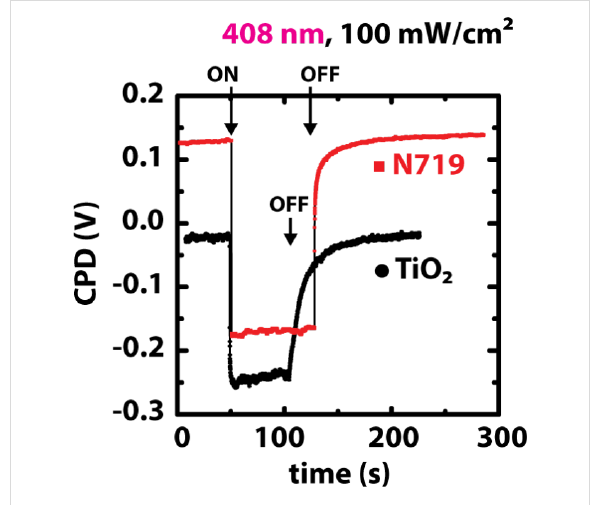
Figure 7: Time evolution of the measured CPD of TiO 2 and TiO 2 + N719 during the turning on and off of the violet (408 nm) laser